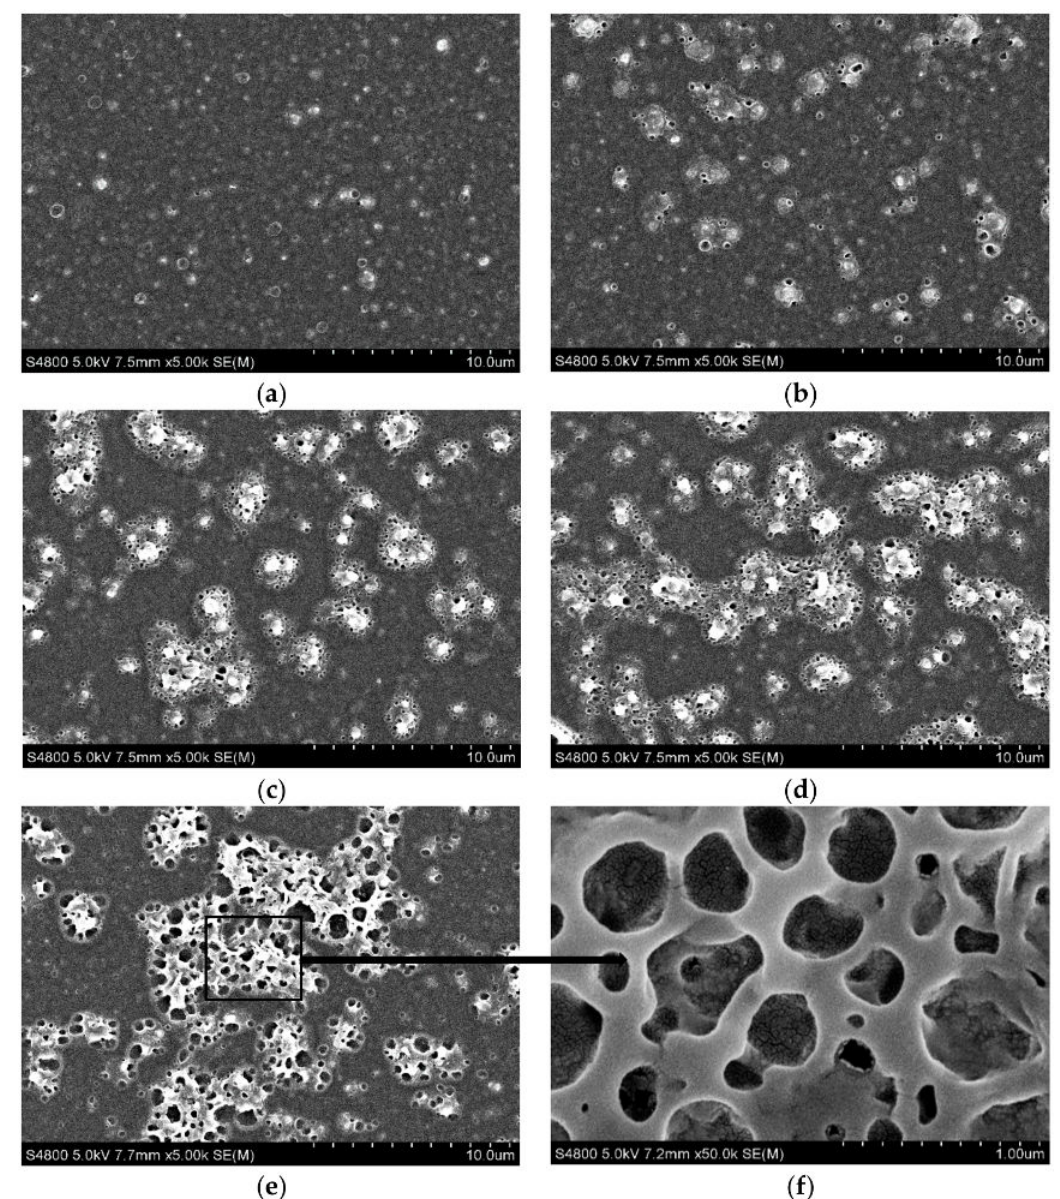
Figure 1. SEM pictures of surface morphology of ( a ) PSf/PA and PSf/PA-SiO 2 composite membrane with the mass fraction of SiO 2 of ( b ) 0.0125 wt %; ( c ) 0.025 wt %; ( d ) 0.05 wt %; ( e ) 0.075 wt % in the magnification of 5000 times; ( f ) the specialized area of ( e ) in the magnification of 50,000 times. Figure 2 show the smooth area of cross section of the PSf/PA and PSf/PA-SiO 2 composite membranes, the PSf/PA membrane shows a dense PA layer and the thickness ranges from 56 nm to 85 nm. However, after the introduction of SiO 2 , the PSf/PA-SiO 2 composite membranes show a more inhomogeneity thickness and are thicker than the controlled PSf/PA membrane, particularly at high concentration of SiO 2